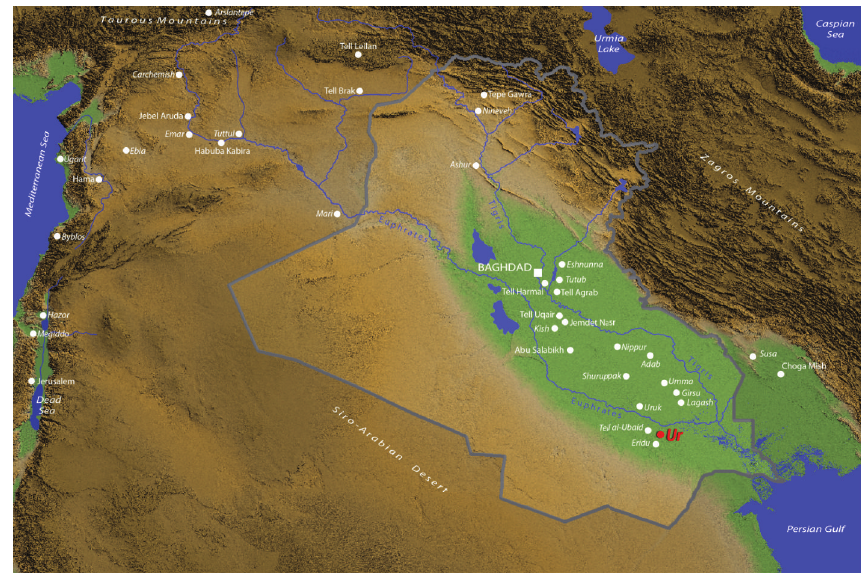
Figure 1: Ur in the southern Mesopotamia (Digital Elevation Model processed from the Shuttle Radar Topography